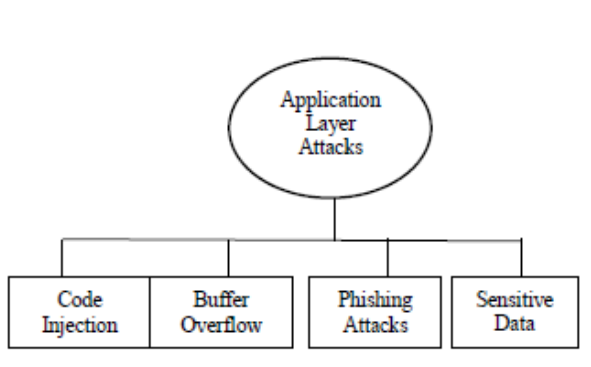
Figure 5. Application Layer